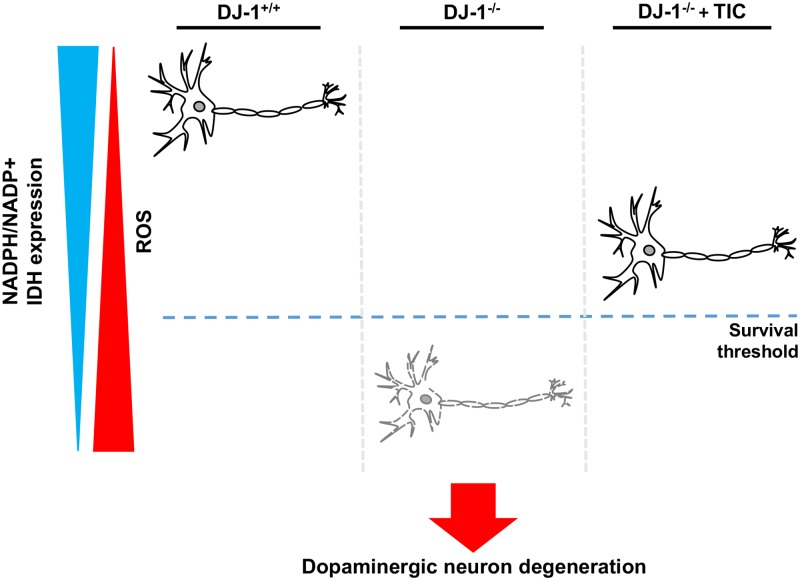
Schematic models of the protective effects of IDH on DA neurons against oxidative stress in DJ-1 null background.